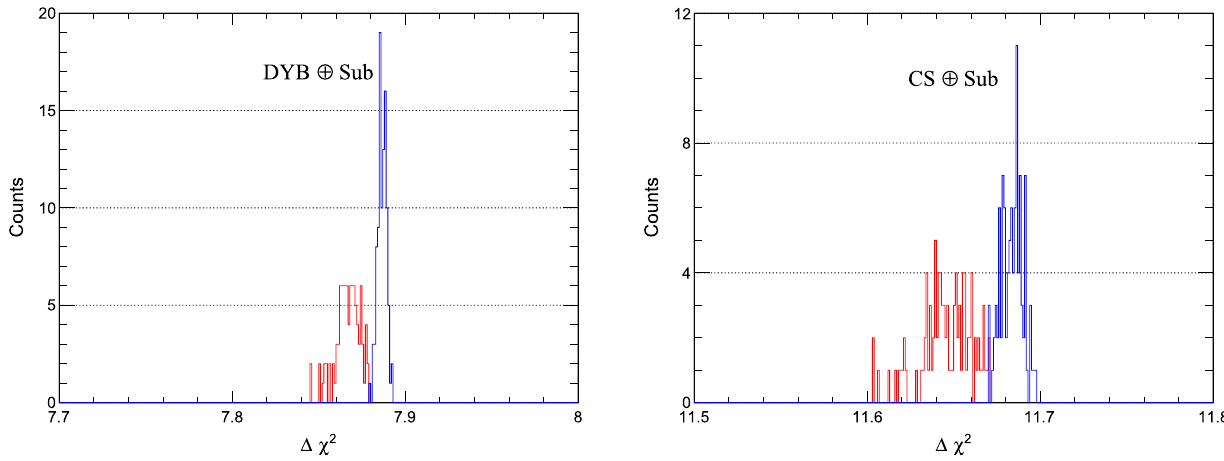
Fig. 6 Sensitivities from spectra with inputs varied within their uncertainties based on ENDF (red) and JEFF (blue). The left panel shows results based on Daya Bay shape uncertainties and the right shows results based on 1% shape uncertainty